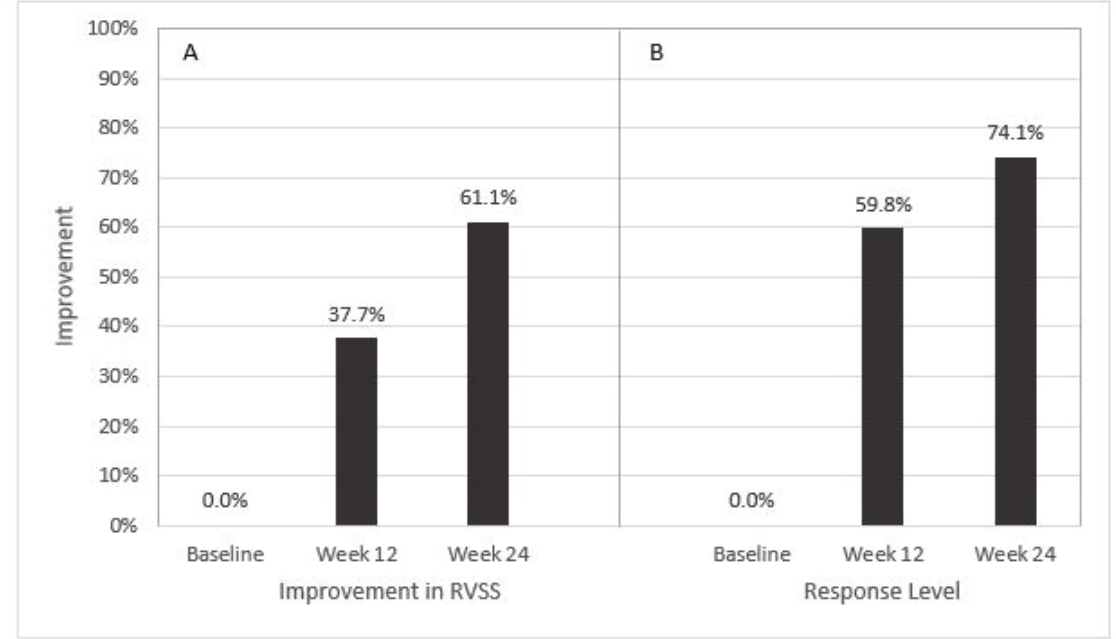
Figure 2. Comparison of response level (RL) between objective retinal vasculitis scoring system (A) and subjective retinal vasculitis scoring system (B).